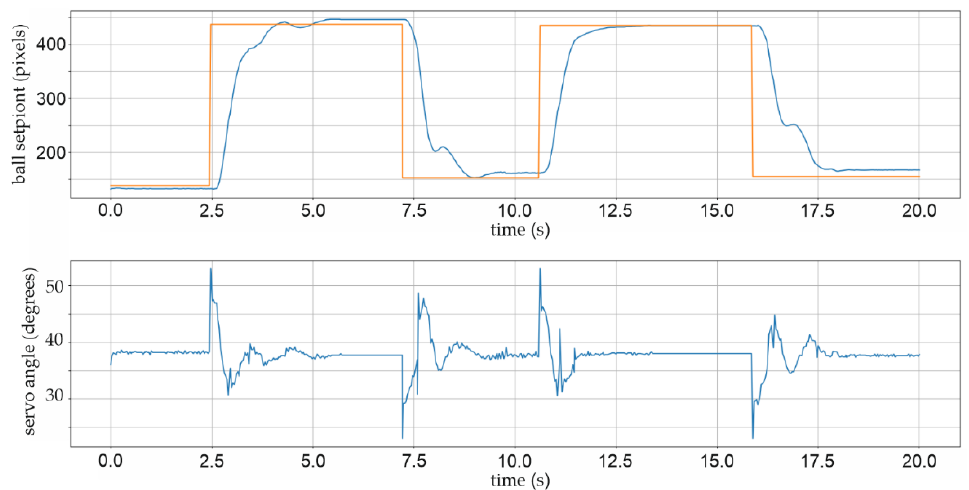
Figure 22. Experiment with kP = 0.030; kI = 0; kD = 0.020; ball stabilization after two seconds.